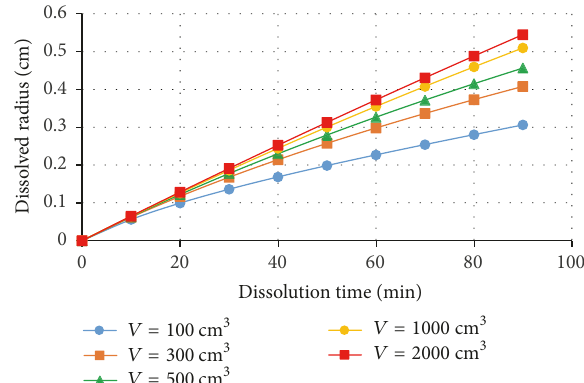
Figure 8: Change of the dissolved radius with dissolution time for different dissolution areas ( 𝐴 ).